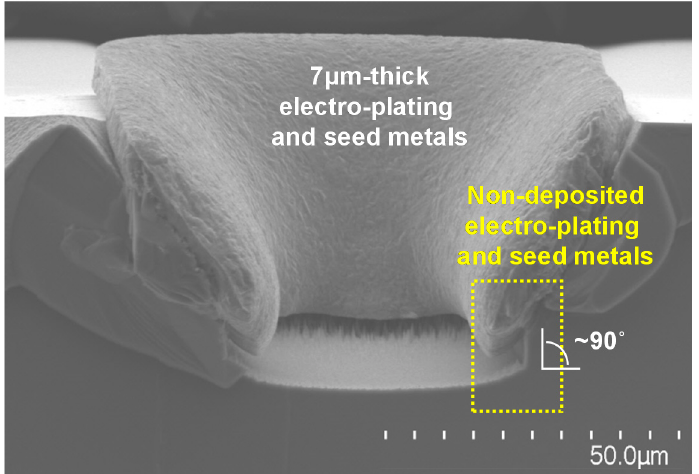
Figure 1. Scanning electron microscope (SEM) images of InP via holes with vertical sidewall slope where electro-plating and seed metals were deposited. Sputtering process for seed metal deposition was performed by using equipment of SRN-110 (SORONA, Anseong, Korea) with a substrate-rotation function.